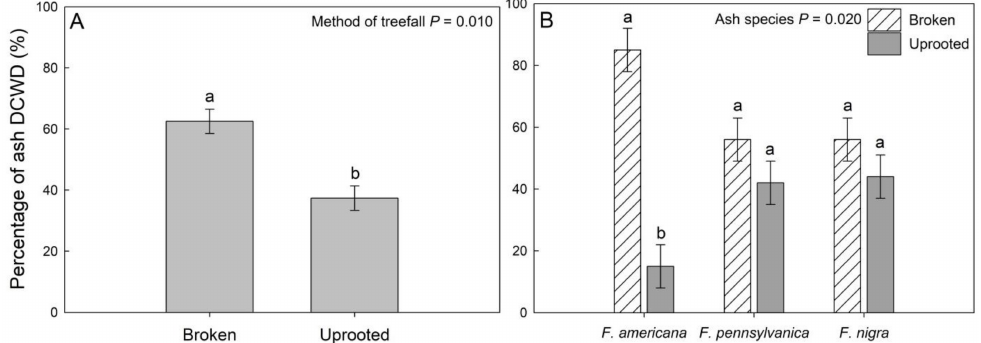
Figure 2. Average percentage ( ± SE) of downed coarse woody debris (DCWD) by method of treefall (broken or uprooted) ( A ) and by ash species (white ash, Fraxinus americana L.; green ash, Fraxinus pennsylvanica Marsh.; and black ash, Fraxinus nigra Marsh.) that fell to the forest floor by breaking (white bars) or uprooting (gray bars); ( B ) in 16 forest stands in the Upper Huron River watershed in southeastern Michigan, USA. Different letters indicate a significant difference at α = 0.05.